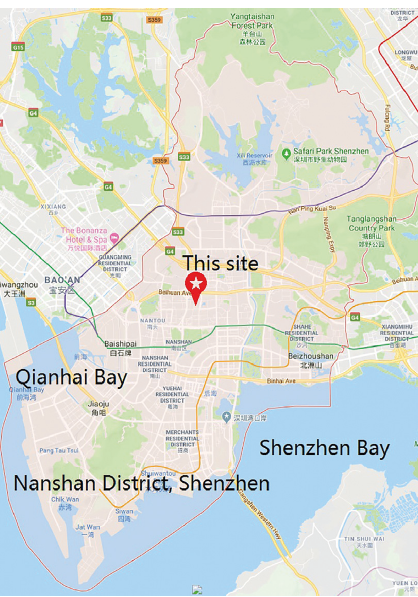
Figure 1: Location map of the experimental site.